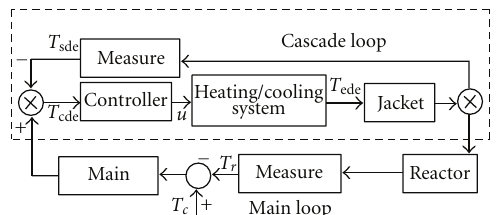
Figure 2: Schematic of the plant block en cascade